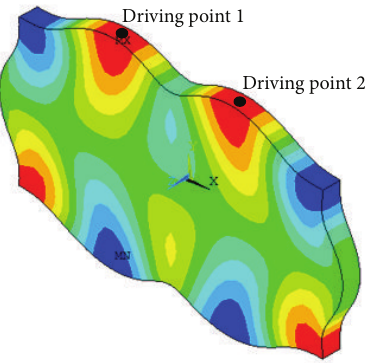
Figure 2: Vibration mode of actuator using double pushers.